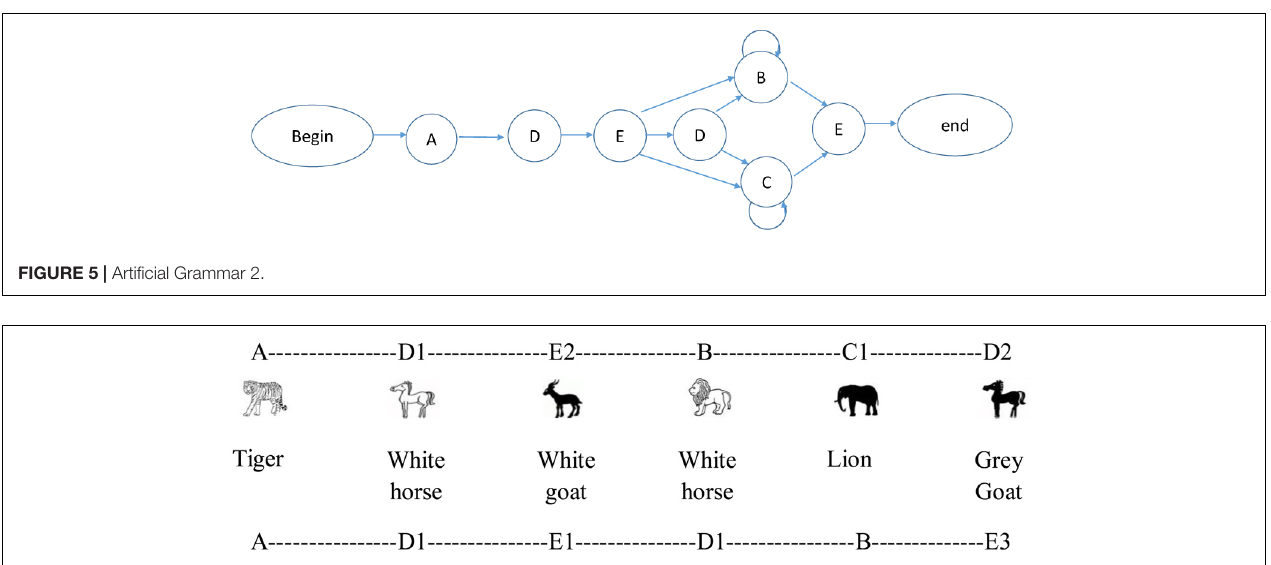
FIGURE 6 | Sample of cross-modal stimuli presentation in Experiment 3. The animal pictures were the visual stimuli (generated from artificial grammar 1) and the animal names were the auditory stimuli (generated from artificial grammar 2) presented in